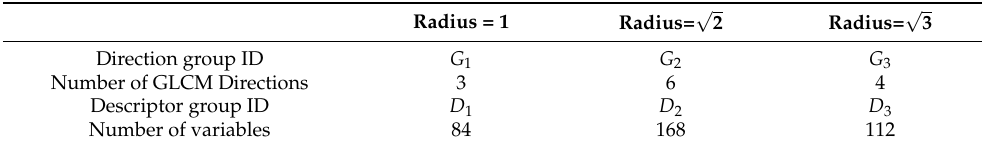
Table 1. Digital direction subdivision by their voxel distances from one voxel to the concerned center